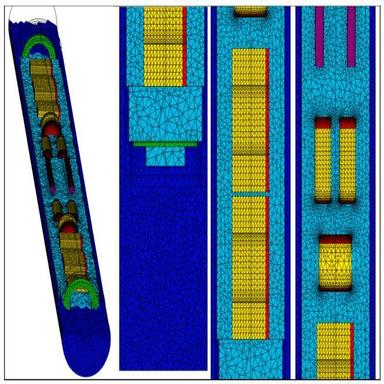
COMSOL mesh for standard capsule.